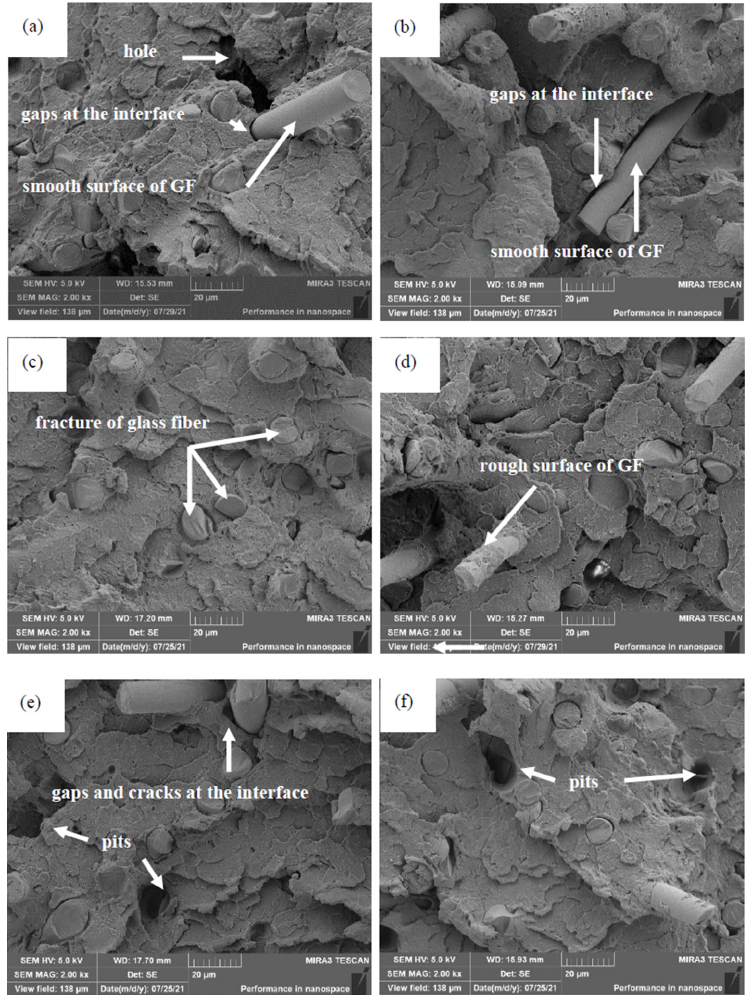
Figure 5. Morphology of tensile fracture of the GF-PC composites. ( a ) Raw material; ( b ) Aged at 85 °C; ( c ) Aged at 100 °C; ( d ) Aged at 115 °C; ( e ) Aged at 130 °C; ( f ) Aged at 145 °C.